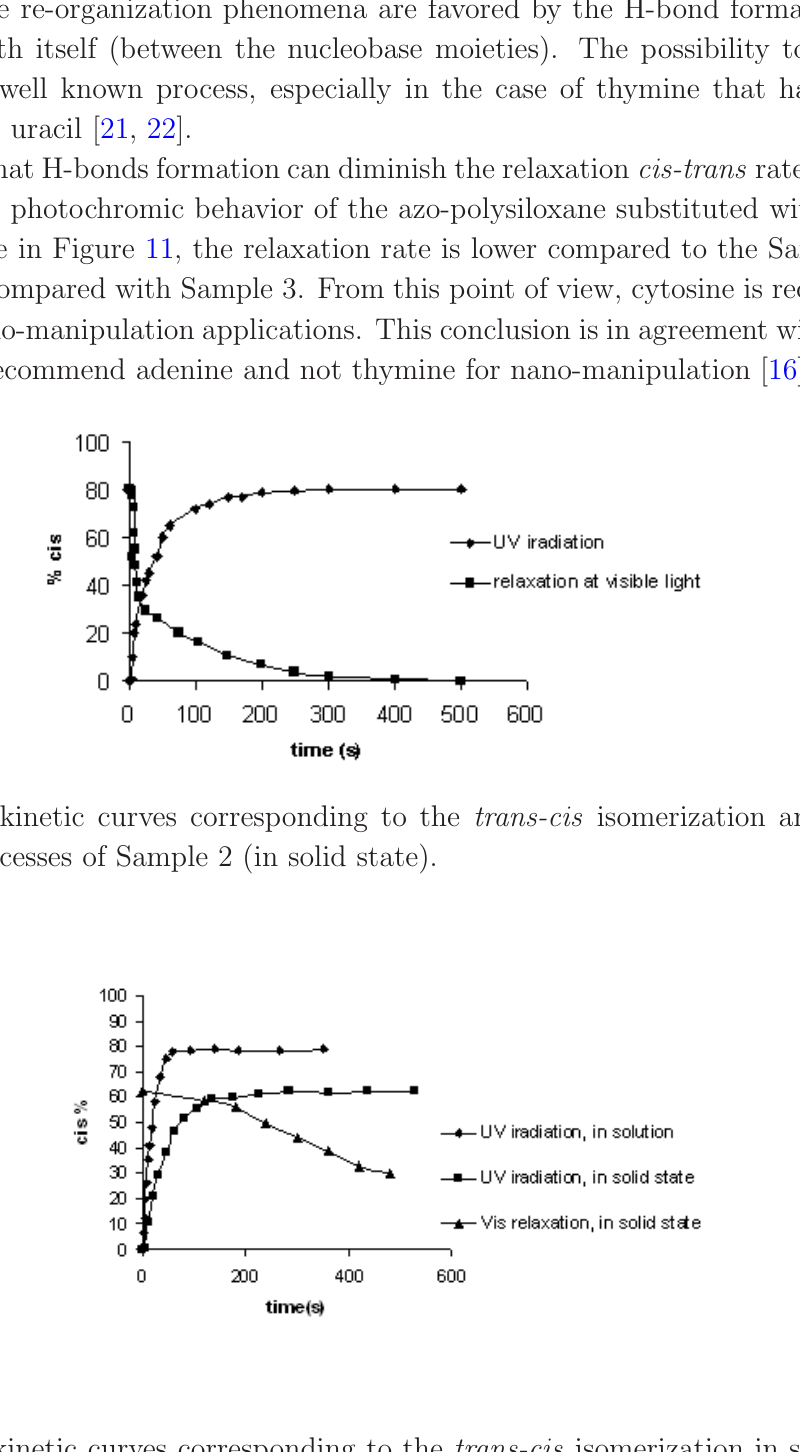
Fig. 11 The kinetic curves corresponding to the trans-cis isomerization in solution and in solid state and cis-trans relaxation processes in solid state of Sample